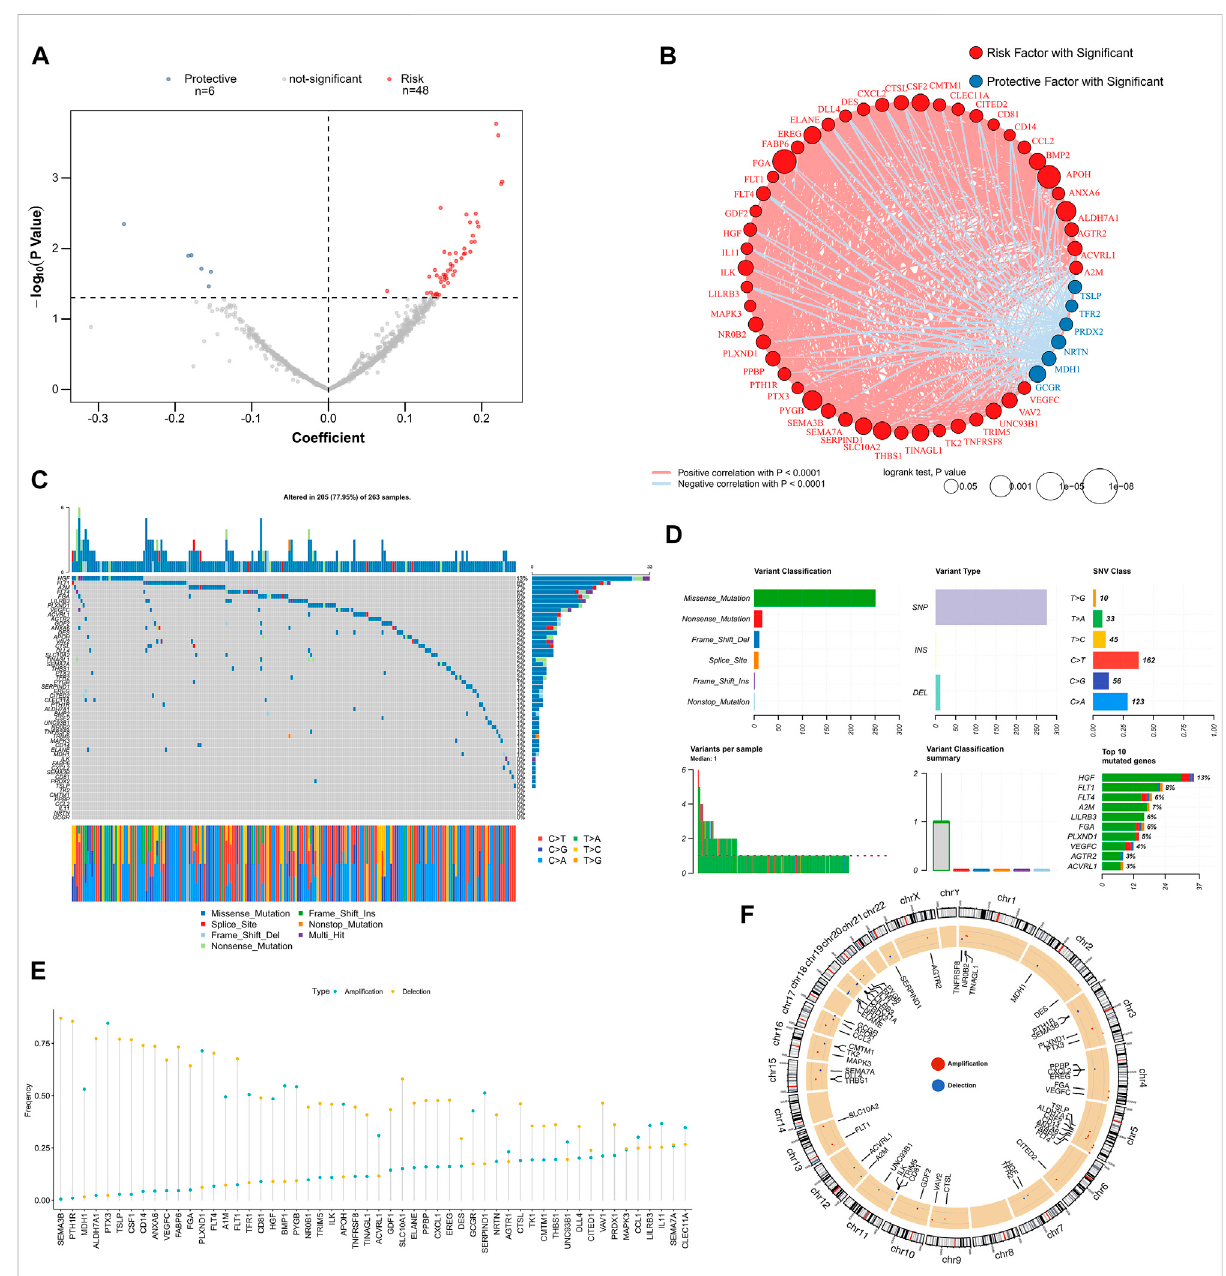
FIGURE 1 Identify prognostic-related GRGs and IRGs. (A) The volcano map illustrates the results of the univariate Cox analysis. (B) Correlation network of prognosticGRGsandIRGs. (C) OncoplotdisplaysmutationmapsofprognosticGRGsandIRGs. (D) SummaryofprognosticGRGsandIRGsmutation events in TCGA-LUSC. (E) Summary of CNV events for prognostic GRGs and IRGs in TCGA-LUSC. (F) The circle diagram presents the CNV maps of prognostic GRGs and IRGs on chromosomes. CNV, copy number variation; IRGs, immune-related genes; GRGs, glycolysis and immune score; TCGA-LUSC, The Cancer Genome Atlas Lung Squamous Cell